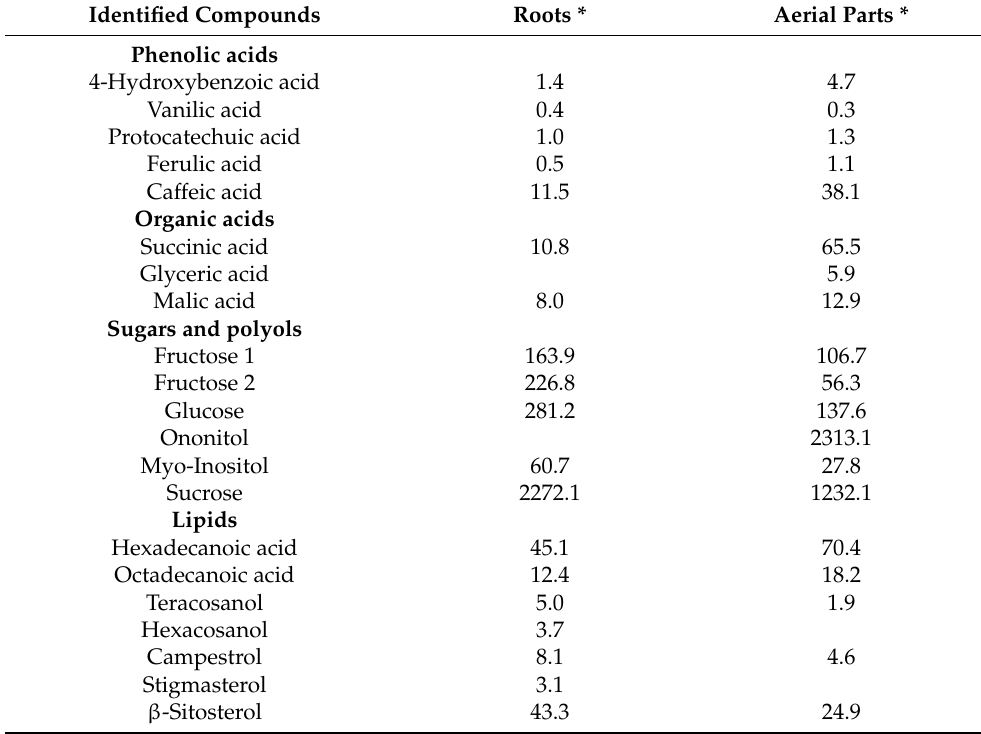
Table 1. Comparative summary data on metabolite profile of the aerial parts and roots of the studied A. tinctoria